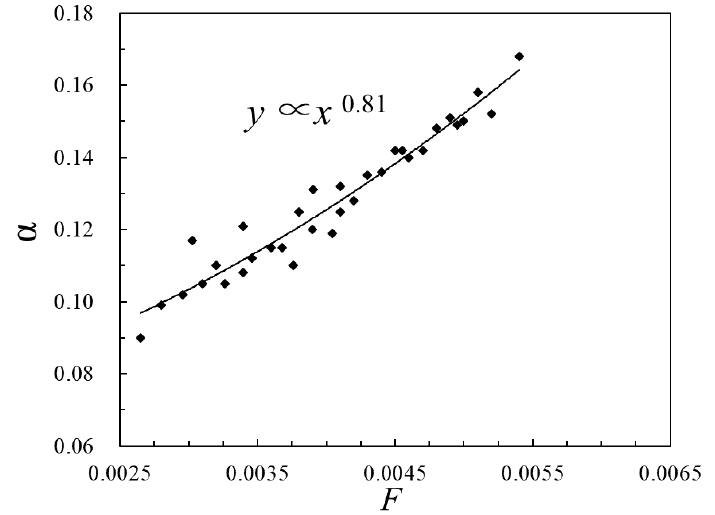
Figure 11. Relationship between F and the gas fraction α .